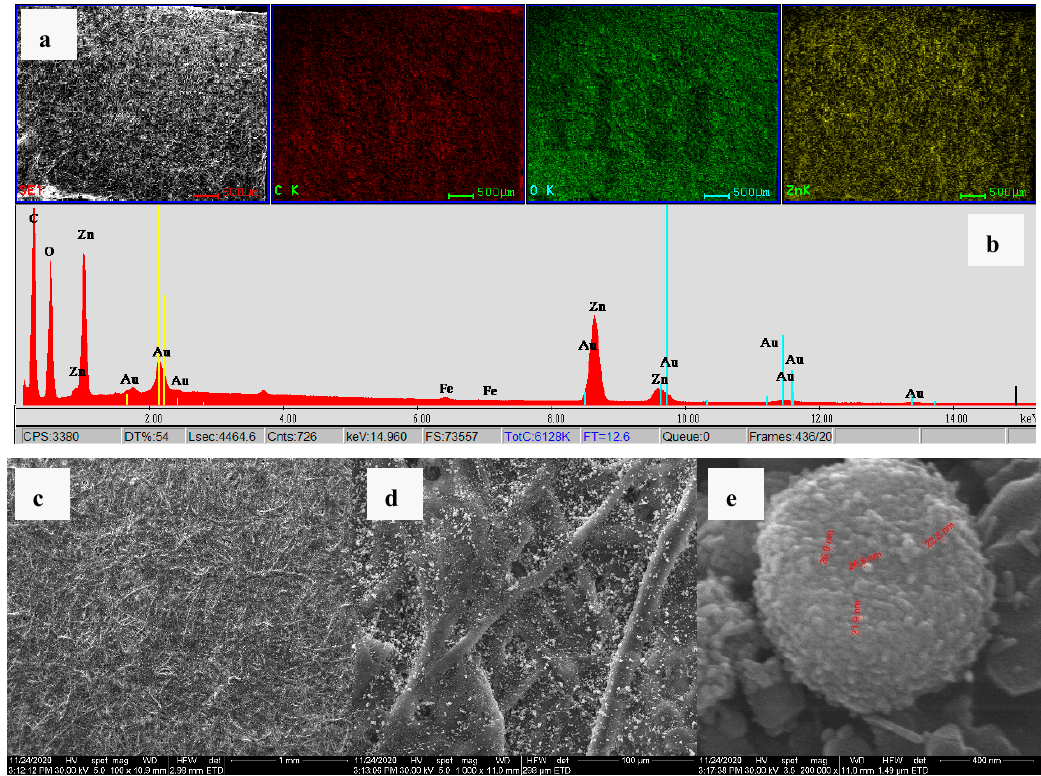
Figure 9. SEM and EDS elemental mapping for ZnO treated paper. SEM image ( a ) with elemental distribution: carbon–red; oxygen–green and zinc–yellow at 60×. Energy dispersive X-ray spectrum ( b ). EDX spectrum of the treated sample, with lines from C, O and Zn as elements composing the sample (Au lines are due to conducting thin film deposition), ( c ) SEM image at 100 × magnification, ( d ) SEM image at 1000 × magnification with clear ZnO agglomerates inside the fibrillar structure of paper, ( e ) SEM image at 200k × magnification with individual nanoparticles